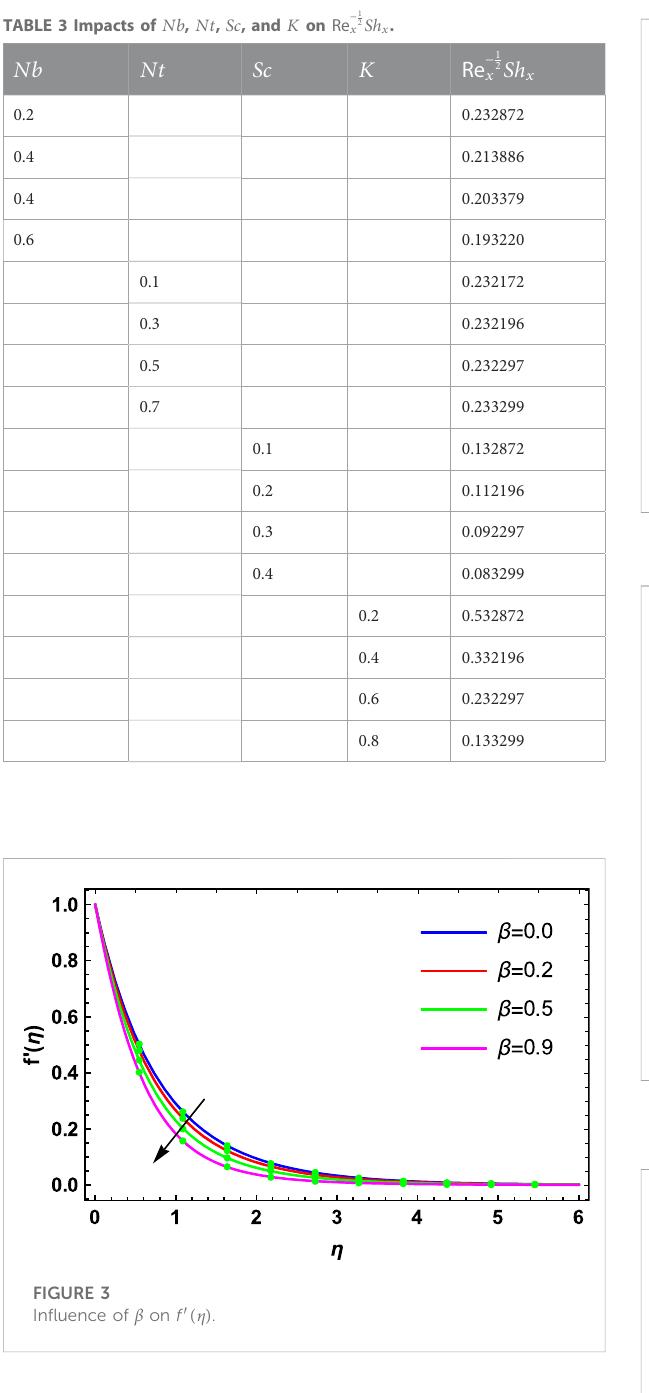
In fl uence of β on f ′ ( η ) .